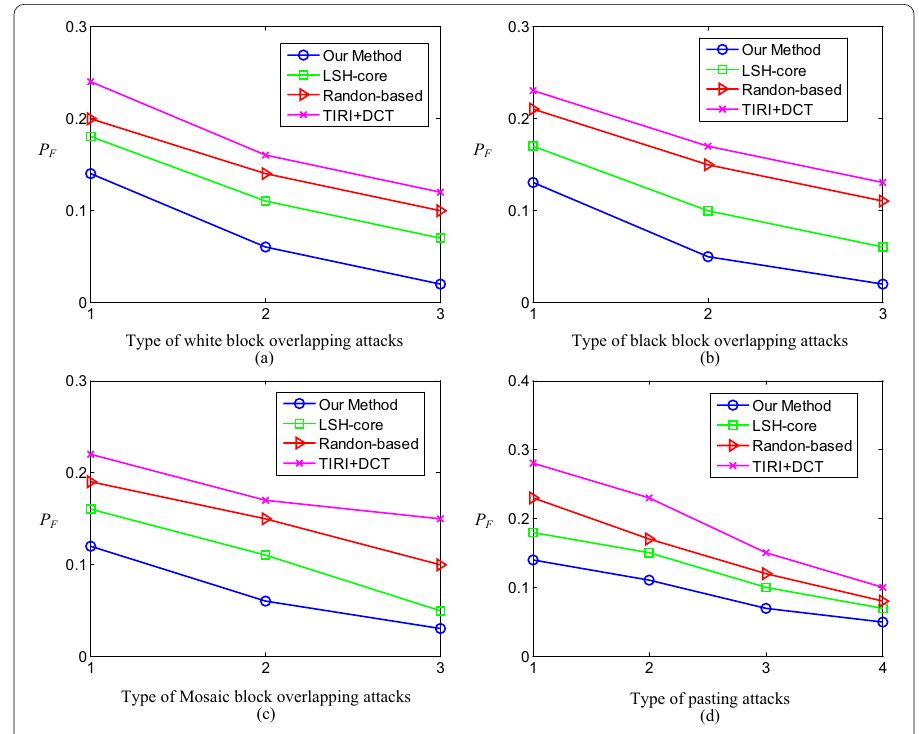
Fig. 6 False positive rate comparisons across different types of attacks. Here shown are the comparisons of false positive rate for four methods under different types of attacks. The upper left panel is for the type of white block overlapping attacks with block size growing; the upper right panel is for the black block overlapping attacks with block size growing; the lower left panel is for the white Mosaic overlapping attacks with block size growing; the lower right panel is for the pasting attacks with pasting area